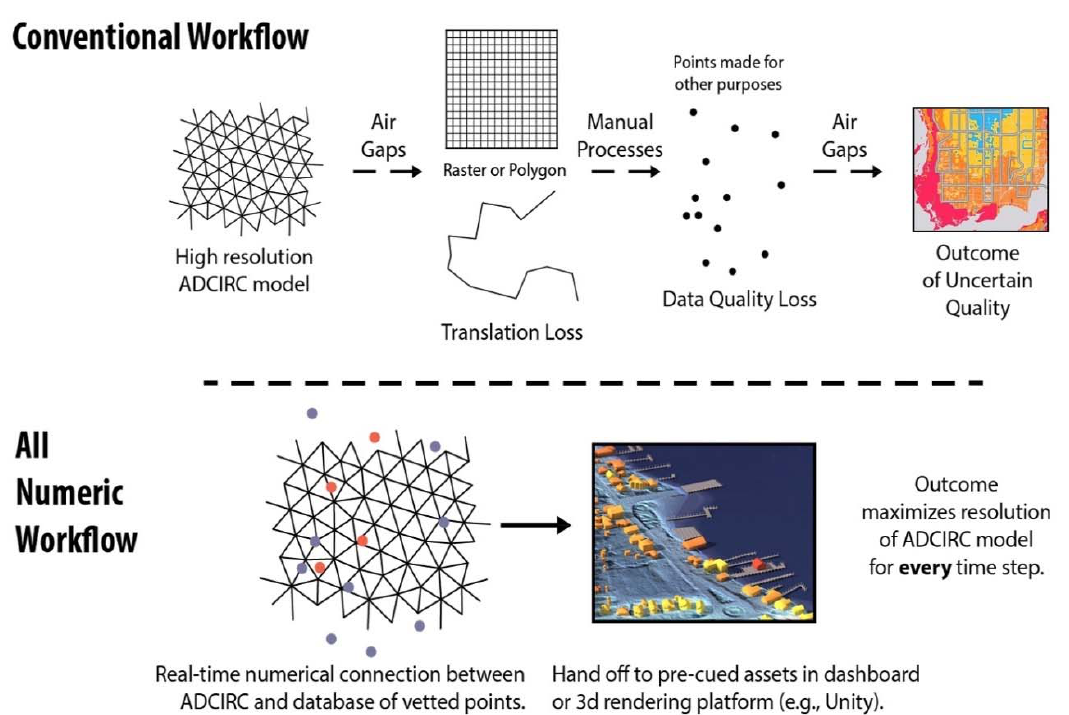
Figure 6. Comparison of conventional workflow and all numeric workflow. Image: Authors.